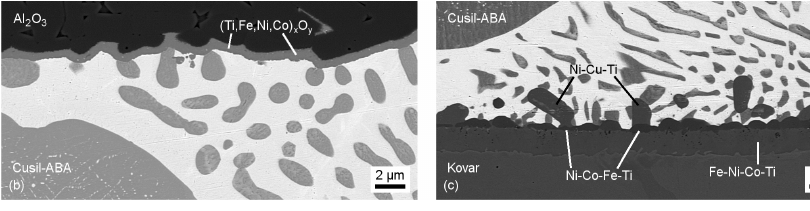
Figure 11. Enlarged SEM images of Fig. 10a showing the Al 2 O 3 –Cusil-ABA (a) and the Kovar–Cusil-ABA interfaces (b)